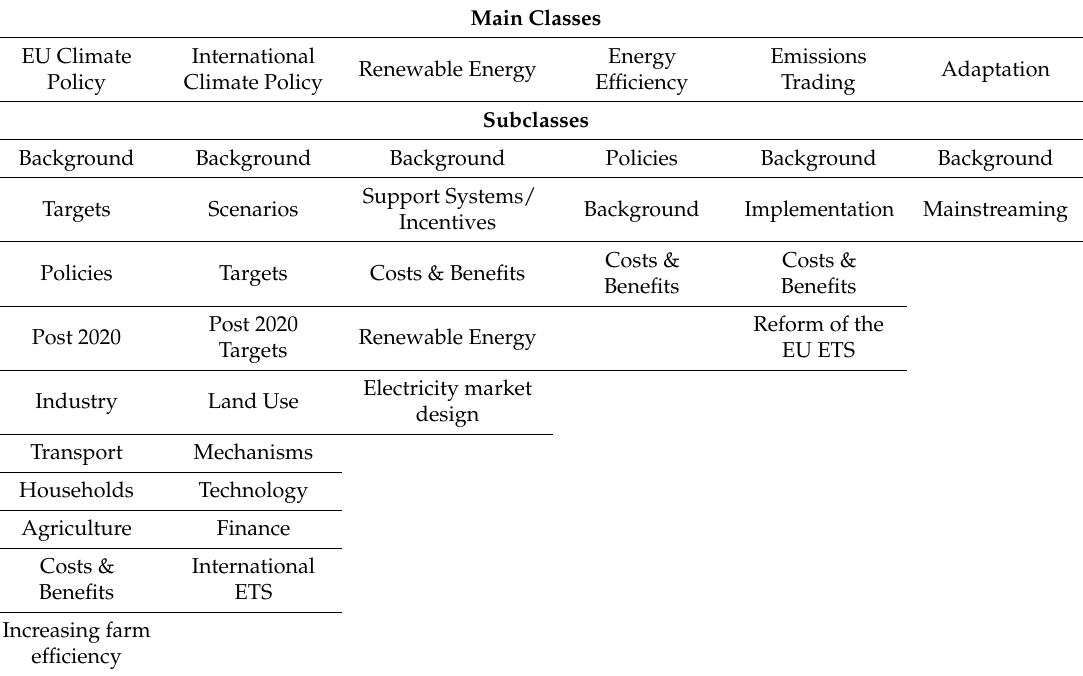
Table 4. Main Classes and Sub-classes of the Climate Policy Ontology. Main